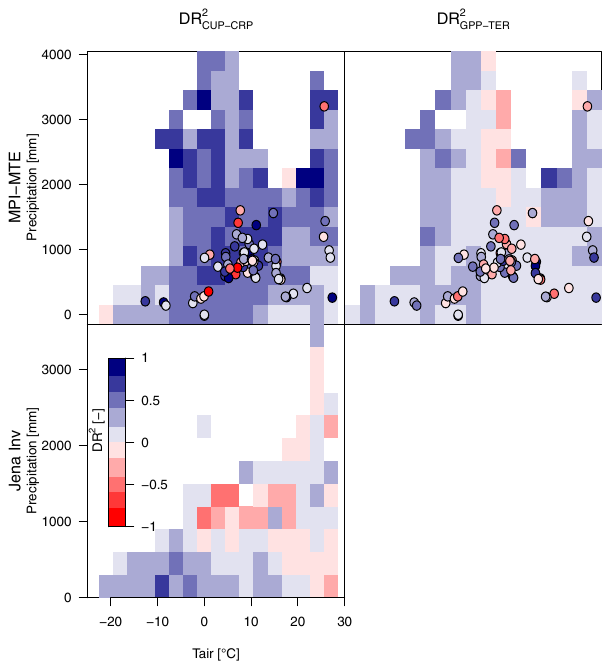
Figure 10. Control on IAV by GPP-TER and CUP-CRP, expressed as the difference of the determination coefficients plotted in a temperature–precipitation space. The two top panels refer to MPI- MTE, while the bottom panel refers to the Jena Inversion; dots refer to FLUXNET sites.